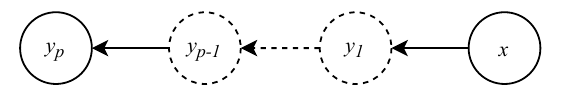
Figure 4. Space-time tradeoff of the hash chain. The nonce x in the figure is hashed p times to generate a hash chain, where y i = hash i ( x )